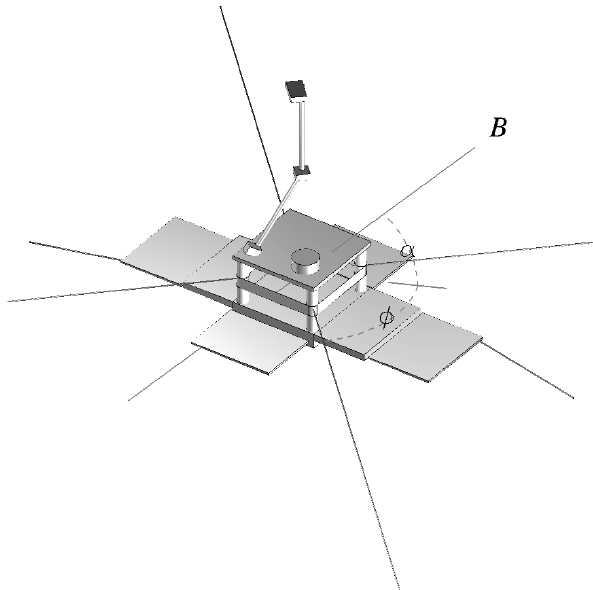
Fig. 1. Schematics of the Astrid-2 microsatellite. LINDA probes are mounted at the stiff booms protruding from the solar panel edges, with probe n 1 on the right side of the figure. The EMMA probes (not shown) are placed at the ends of the wire booms, and numbered clockwise, starting with probe 1 in the top of the figure. α is the angle between the magnetic field and the spin plane, and spin phase φ is measured between the direction of probe 3 and projection of the magnetic field in the spin